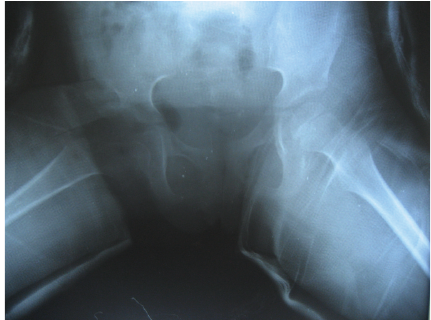
Figure 2: Plain radiograph after open reduction and Pemberton osteotomy.